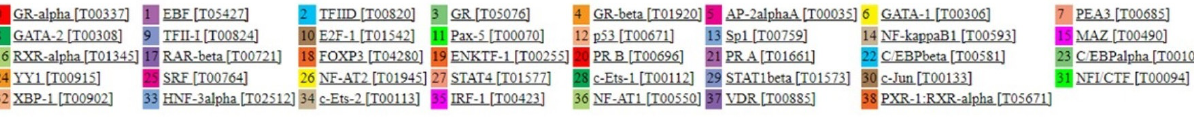
Figure 3. 39 Transcription factors that can bind to the ENPP2 promoter in sites containing DMSs identified in cancer, with a dissimilarity margin ≤ 15%.